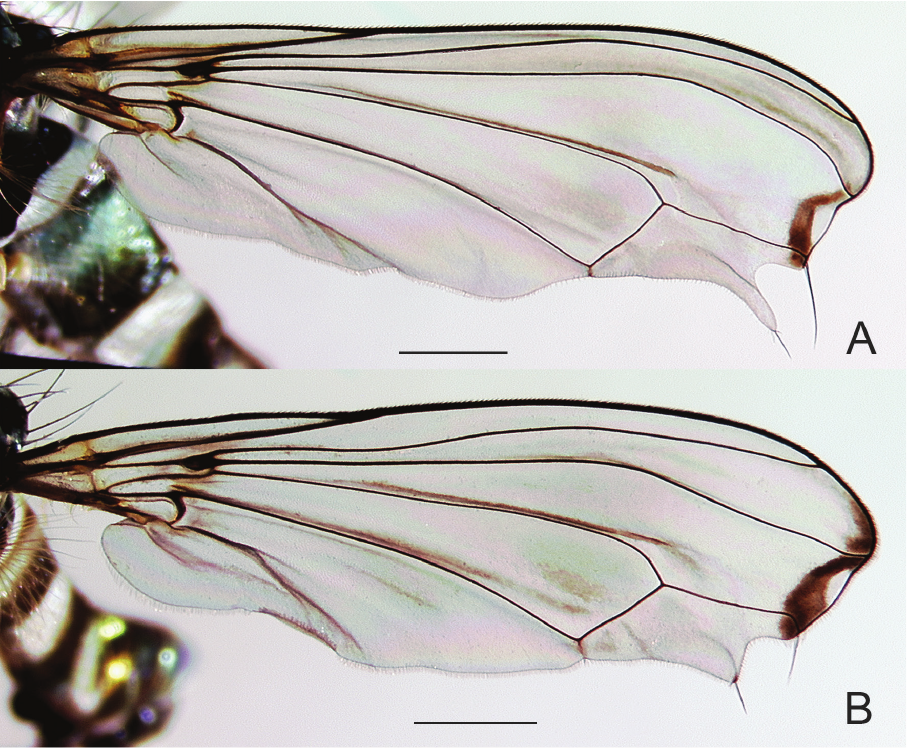
Figure 4. Wings of male A Liancalus pterodactyl sp. n., and B L. hydrophilus Aldrich. Scale bars = 1